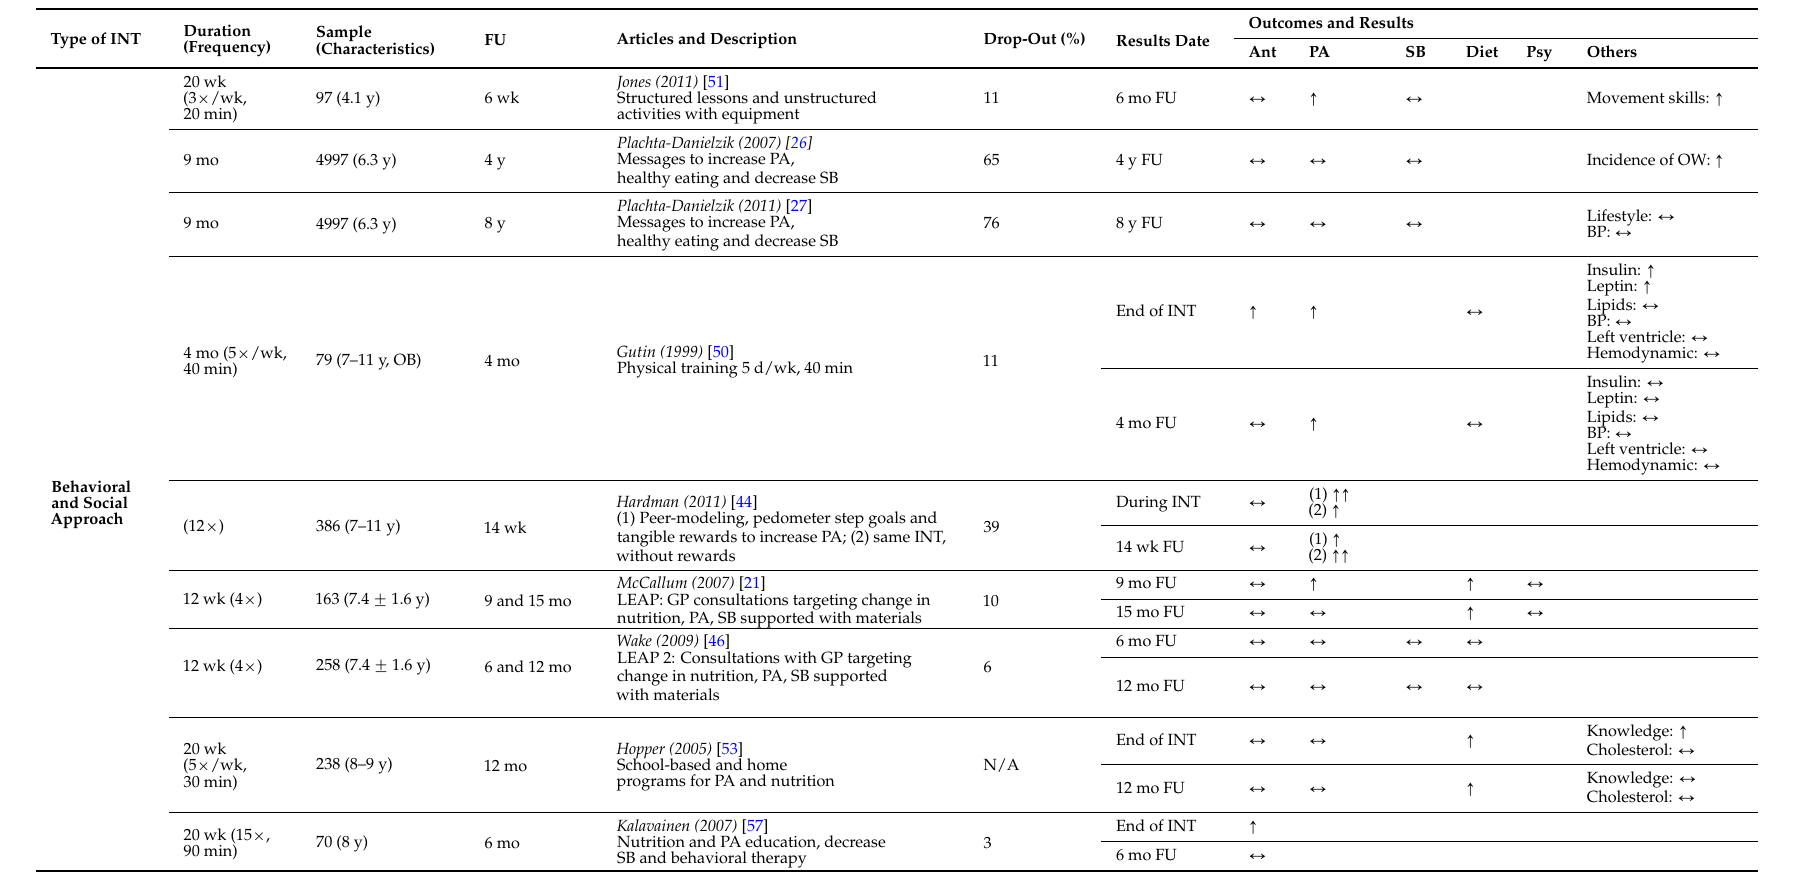
Table 1. Physical activity interventions with control groups ( n =